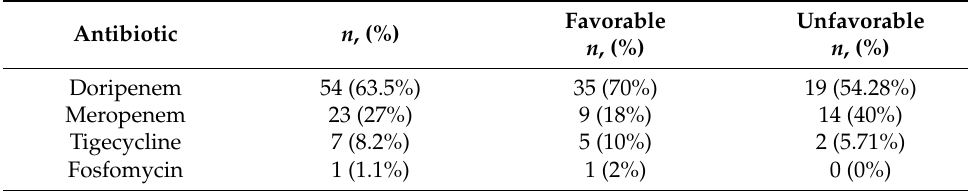
Table 4. Concomitant medication.